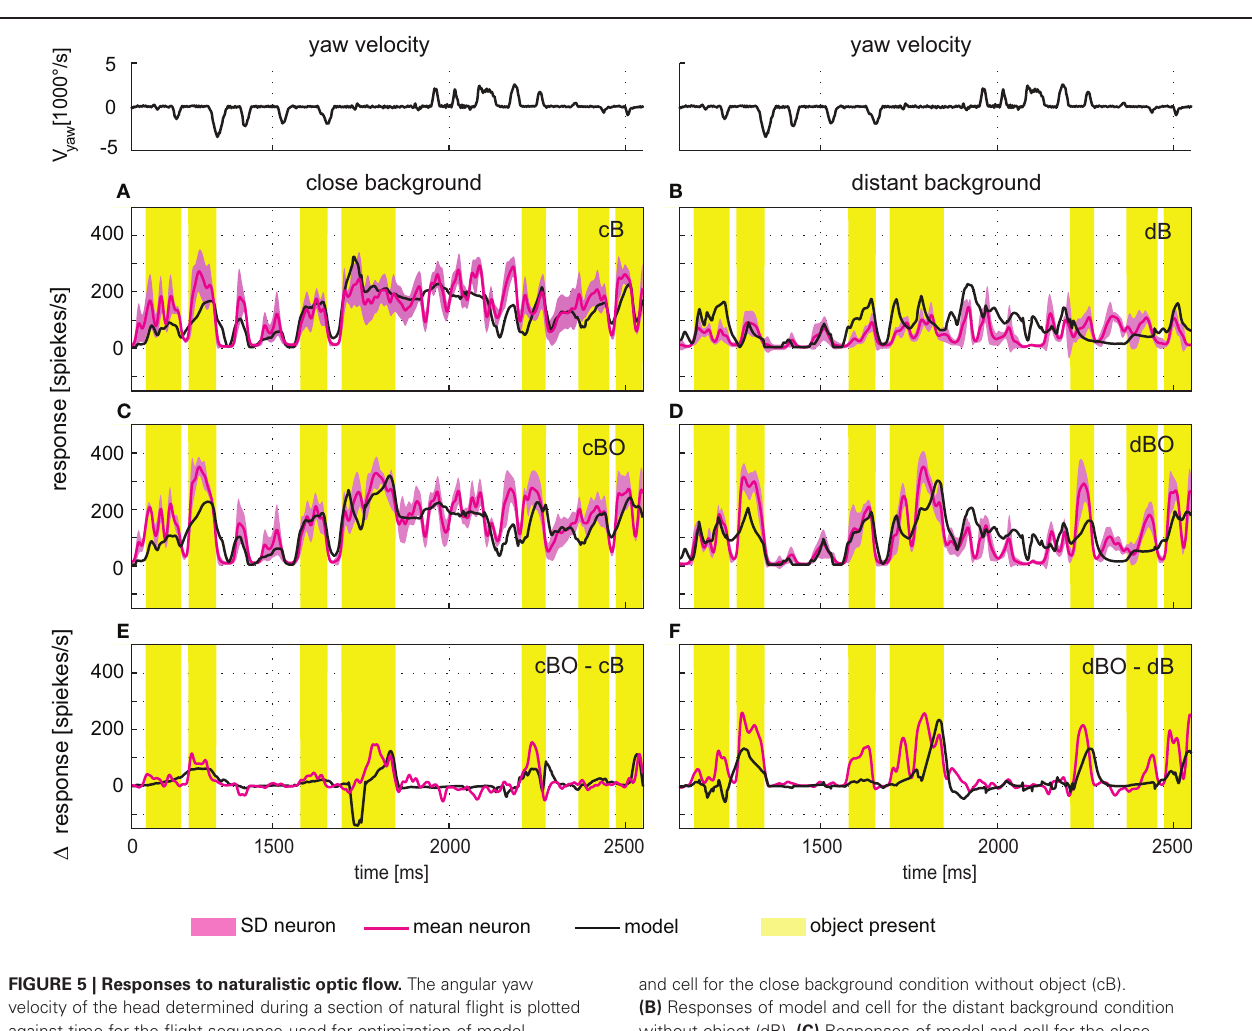
and cell for the close background condition without object (cB). (B) Responses of model and cell for the distant background condition without object (dB). (C) Responses of model and cell for the close background condition with object (cBO). (D) Responses of model and cell for the distant background condition without object (dBO). (E) Difference between the responses obtained under the cBO and cB conditions. (F) Difference between the responses of the dBO and dB conditions. Model response differences are plotted in black, and cell response differences in red. Experimental data were collected in a parallel study [Liang et al.